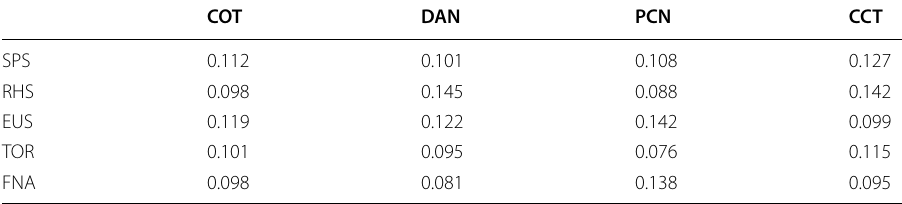
Table 13 Weighted decision matrix for the amplitudes of quantum membership degrees COT